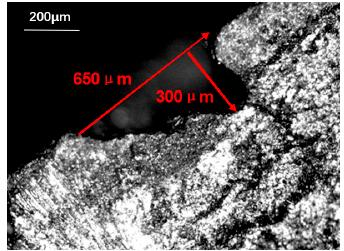
Figure 8. Equivalent test method for pores.